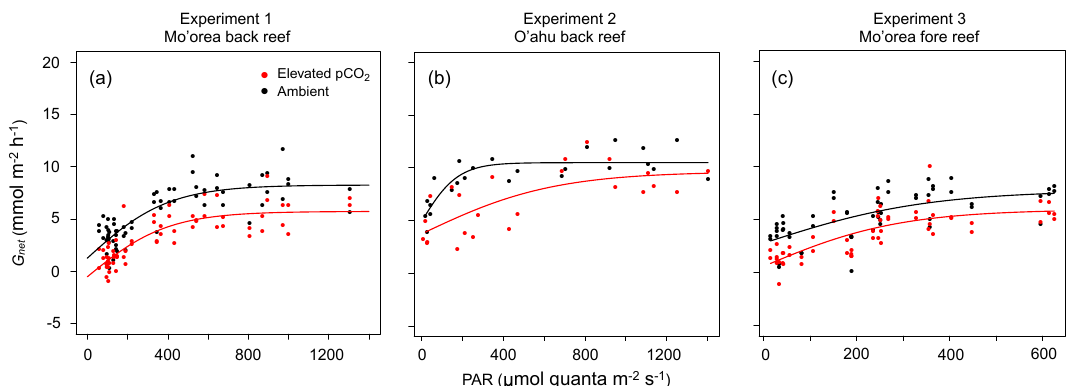
Figure 3. Relationships of net calcification ( G net ) in the light with PAR in three coral reef communities representing the back reef of Mo’orea (a) , the back reef of O’ahu (b) , and the fore reef of Mo’orea (c) . Communities were incubated under ambient p CO 2 ( ∼ 400µatm, black symbols and lines) and elevated p CO 2 ( ∼ 1200µatm, red symbols and lines). The curves represent the best fit of a hyperbolic tangent function for the relationship between G net and PAR.